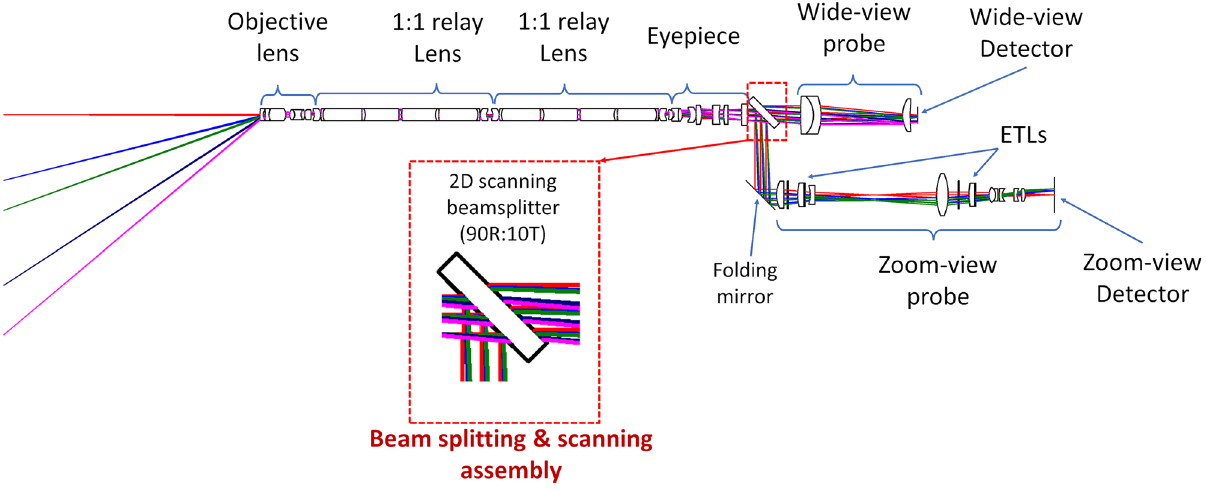
Figure 3. Optical layout of an MRFL